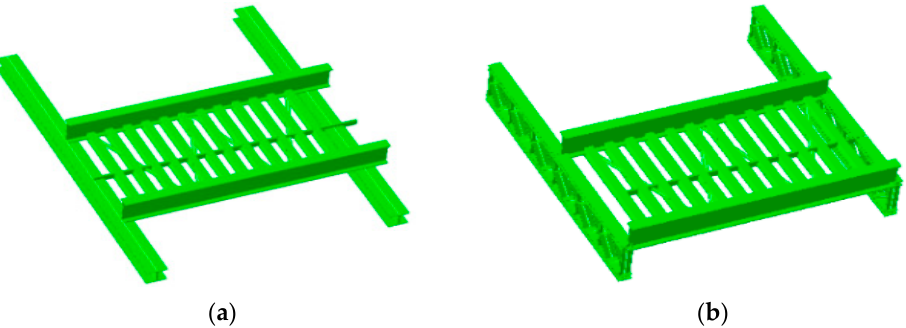
Figure 5. One-span model diagram of track and overhead system: ( a ) A cross model diagram type I aerial system. ( b ) A cross model diagram type II aerial system.